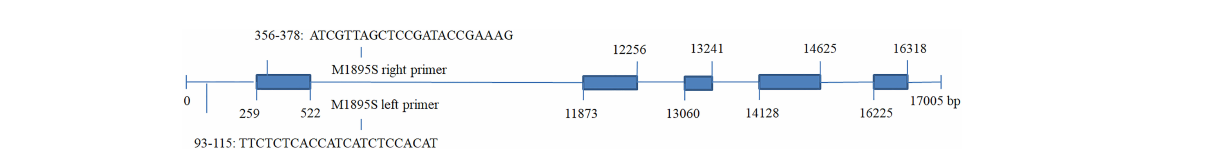
FIGURE 2 Positions of left and right primers of M1895S, and exons in the SjPT gene closely associated with QTL for blade length and width in S.japonica . *Blue blocks represent fi ve exons and lines between the blue blocks represent introns in the SjPT gene.